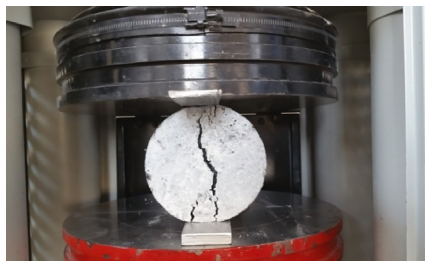
Figure 1: Split-tensile strength